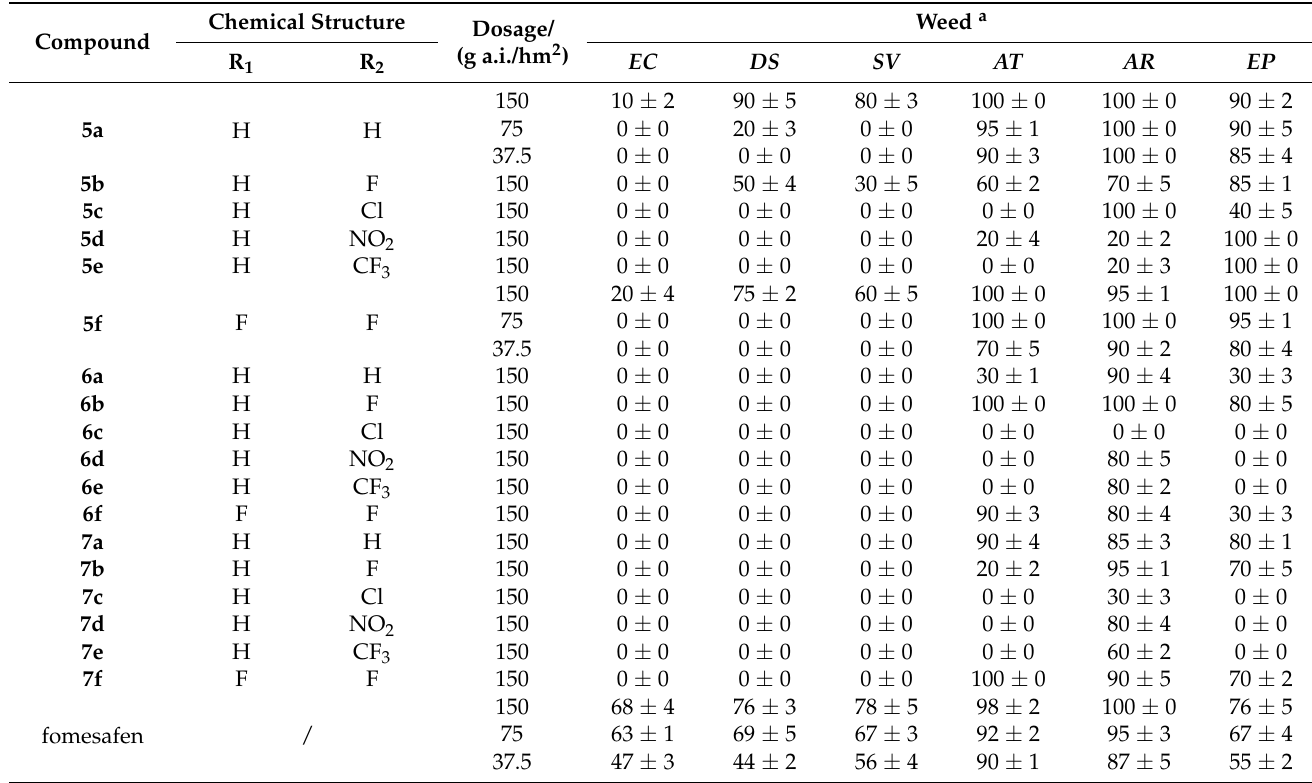
Table 1. The structures and herbicidal activities of α -trifluoroanisole derivatives for post-emergence treatment in a greenhouse assay setting.